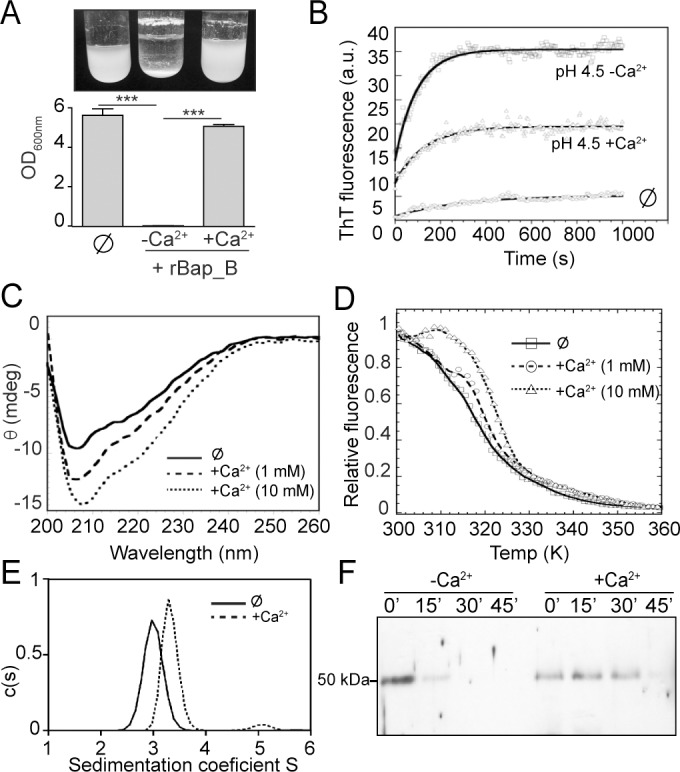
Effect of calcium in rBap_B structure.A) Bacterial clumping of S. aureus Δbap grown in LB-glu (pH<5) incubated with 2 μM purified rBap_B protein in the presence or absence of 20 mM CaCl2. ⊘, no addition of rBap_B. Cells were incubated for 24 h with agitation at 37°C. Statistical analysis was carried out using the unpaired Student t test (***, P<0.001; n = 4). B) Aggregation kinetics of rBap_B were monitored by following the changes in relative ThT fluorescence. rBap_B at pH 4.5 (squares), rBap_B at pH 4.5 + 100mM CaCl2 (triangles), and rBap_B at pH 7 (⊘, circles) are represented. C) Far-UV CD spectra of 0.2 mg/ml rBap_B at pH 7 in the absence (solid line) or presence of 1 mM (dashed line) and 10 mM (dotted line) CaCl2. D) Thermal melting curves of 0.2 mg/ml rBap_B in the absence (square) or presence of 1 mM (circles) and 10 mM (triangles) CaCl2 monitored by intrinsic fluorescence. E) Sedimentation velocity analyses of 1 mg/ml rBap_B in the presence of calcium (dashed line) revealed a specific retard in the sedimentation velocity. The continuous line represents cation-free rBap_B. F) Time course of rBap_B proteinase-K digestion. Immunoblot patterns using anti-BapB antibodies are shown for the protein in the presence (+Ca2+) and absence (-Ca2+) of 50 mM of CaCl2 at 0, 15, 30 and 45 min after proteinase-K addition.